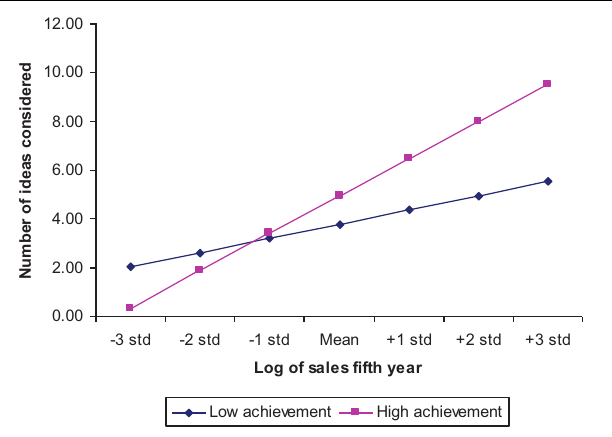
FIGURE 1 | Moderating effects of need for achievement on the relationship between number of ideas considered and wealth aspiration